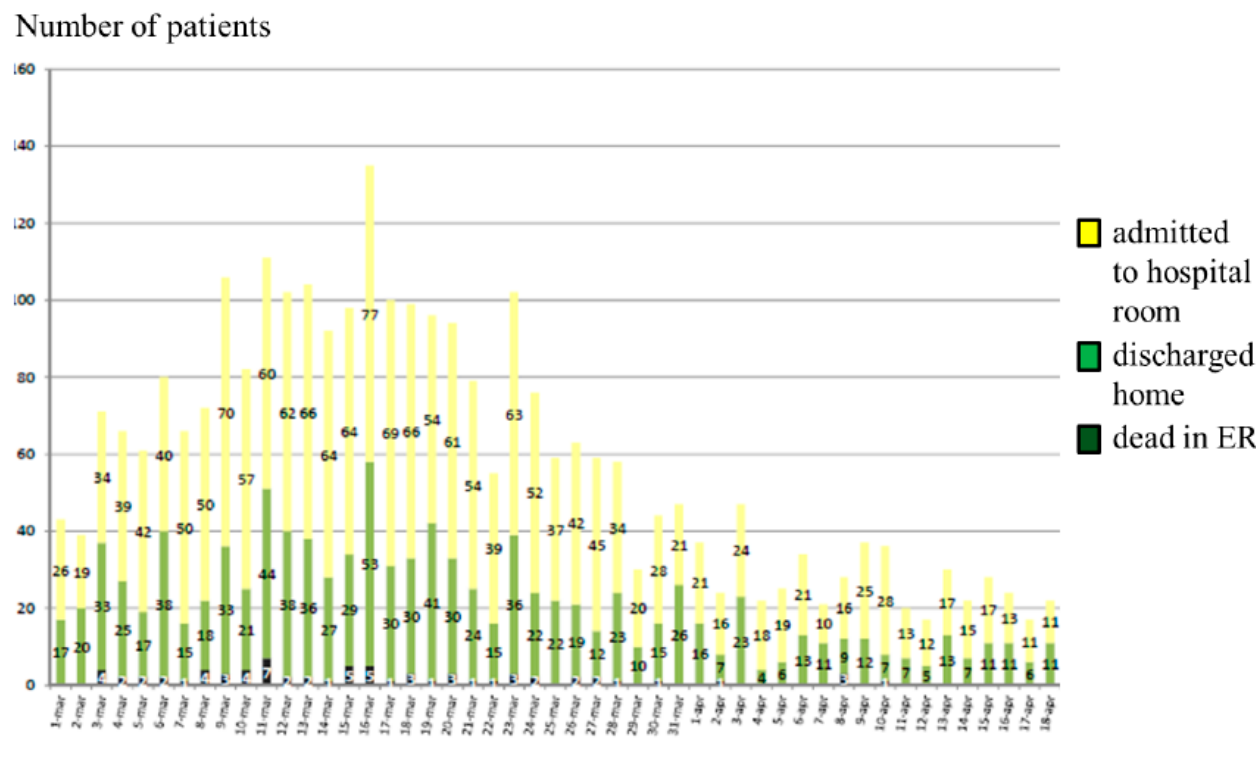
Figure 2. Patients admitted to the ED of Piacenza during the first wave of COVID-19 Italian epi-